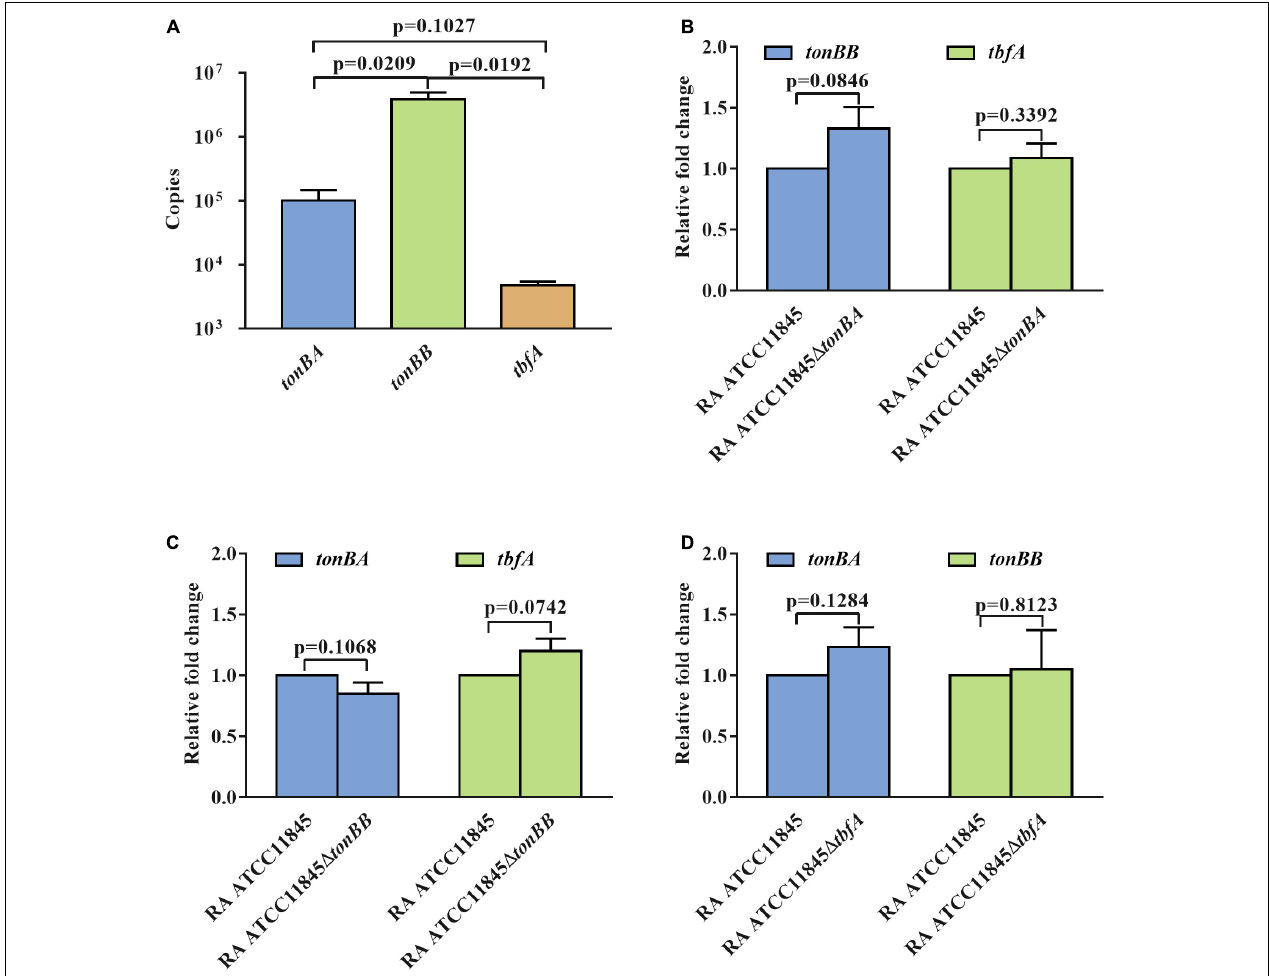
FIGURE 6 | The transcription level of the three tonBs in R. anatipestifer ATCC 11845 and its derivative strains. (A) The transcriptional copies number of the three tonBs in R. anatipestifer ATCC 11845. The standard curves of gene copies number and Ct values were established by amplifying tonBA , tonBB , and tbfA from plasmid pLMF03: tonBA , pLMF03 :tonBB , and pLMF03 :tbfA , respectively, using quantitative real-time PCR. Subsequently, the Ct values of three tonBs in R. anatipestifer ATCC 11845 were measured by amplifying tonBA , tonBB , and tbfA from cDNA of R. anatipestifer ATCC 11845. Finally, the transcriptional copies numbers were calculated according to the constructed standard curves. (B) The relative transcription level of the tonBB and tbfA in the tonBA mutant. (C) The relative transcription level of the tonBA and tbfA in the tonBB mutant. (D) The relative transcription level of the tonBA and tonBB in the tbfA mutant. The R. anatipestifer ATCC 11845, tonBA mutant, tonBB mutant, and tbfA mutant were grown in the GCB medium, respectively, until reaching the exponential growth phase and harvested for total RNA extraction and real-time quantitative PCR as described in section “Materials and Methods.” Each experiment consisted of